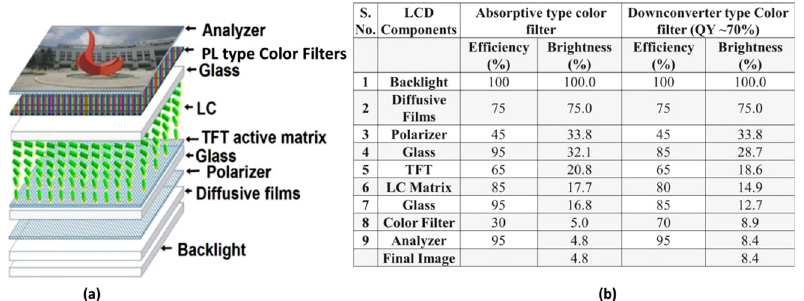
Figure 19: (a) Conventional LCD structure, (1) backlight unit, (2) diffusive films, (3) polarizers, (4) glass substrate, (5) TFT array, (6) Liquid crystals,(7)glasssubstrate,(8)PLtypecolorFilterand(9)isthepolarizer,and(b)theproposedLCDstructurewithdownconvertercolor fi lters. (1)backlightunit,(2)diffusive fi lms,(3)polarizers,(4)Color fi lters(5)glasssubstrate,(6)TFTarray,(7)Liquidcrystals,(8)glasssubstrate,and (9)is the polarizer. (b) isthe LCDstructurewith invertedcolor fi lter.(c) representstheenergyeconomics of the conventional LCDandLCDwith inverted downconverter color fi lters